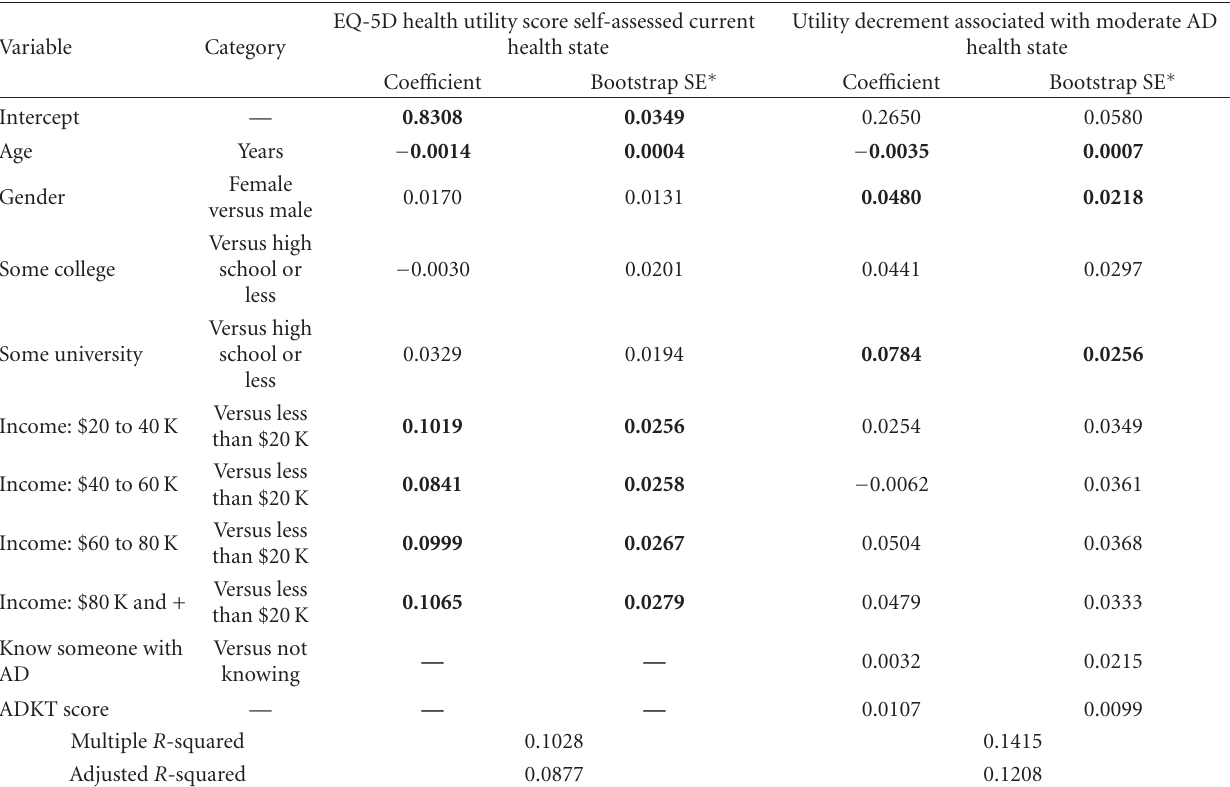
Table 3: Regression analyses: EQ-5D utility score and perceived utility decrement associated with a hypothetical moderate AD health state (weighted results).